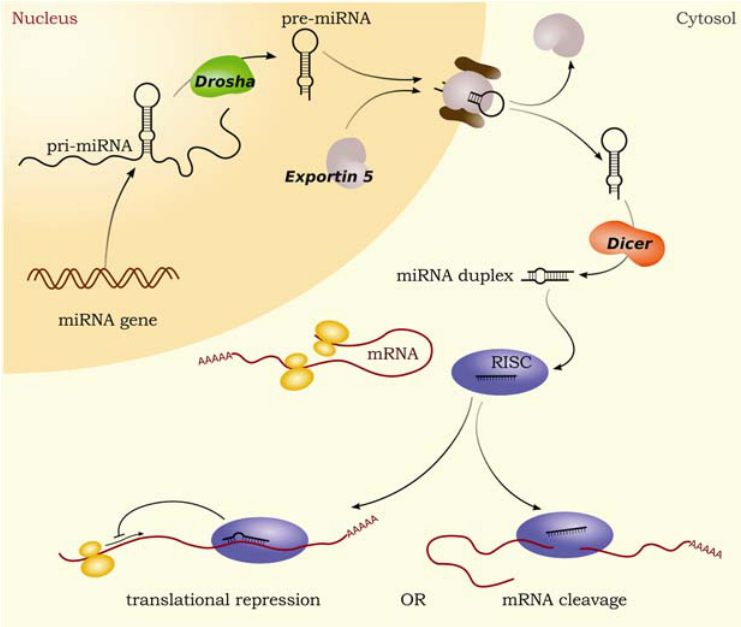
FIGURE 1. microRNA biogenesis and modes of action. For details see